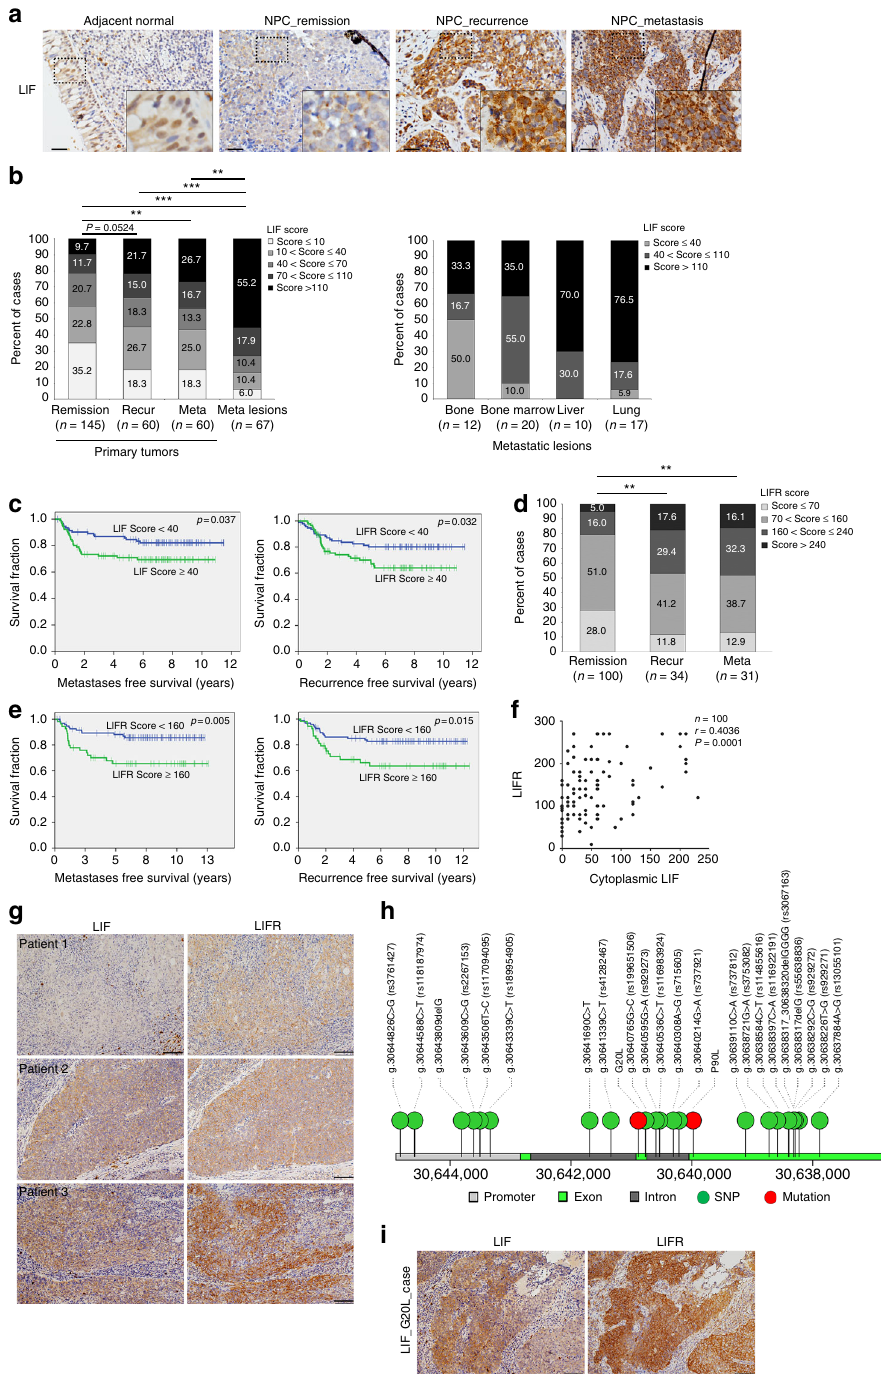
Fig. 1 Elevated cytoplasmic LIF and LIFR in NPC are correlated with poorer prognosis. a Representative images of LIF expression in adjacent normal epithelium and NPC tumor tissues. Scale bars, 20 μ m. b Statistical analysis of cytoplasmic LIF expression in primary NPC tumor tissues and metastatic lesions. Analysis of cytoplasmic LIF expression in distinct metastatic lesions is shown (right). ** p < 0.01, *** p < 0.001, chi-square test. c Kaplan – Meier survival curves of NPC patients based on IHC scores of cytoplasmic LIF expression. Metastasis-free survival (left). Recurrence-free survival (right). d Statistical analysis of LIFR expression in NPC tumor biopsies. ** p < 0.01, chi-square test. e Kaplan – Meier survival analysis of NPC patients based on LIFR expression. Metastasis-free survival (left). Recurrence-free survival (right). f Analysis of correlation between cytoplasmic LIF and LIFR expression (Spearman ’ s correlation test). g Representative images of LIF and LIFR expression patterns in NPC tumor tissues. Scale bars, 50 μ m. h Single nucleotide variations in NPC biopsy samples ( n = 157). Circles are colored with respect to the corresponding mutation types. i LIF and LIFR expression in tumors from NPC patient carrying LIF signal peptide mutation (G20L). Scale bars, 50 μ